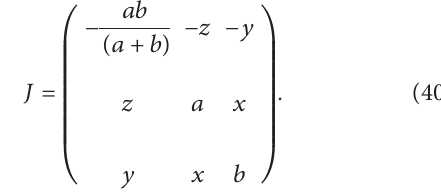
Figure 10: Dynamics of Lu et al.’s fractional-order system in (13)–(15) with the order α � 0 . 88, in context of y and z